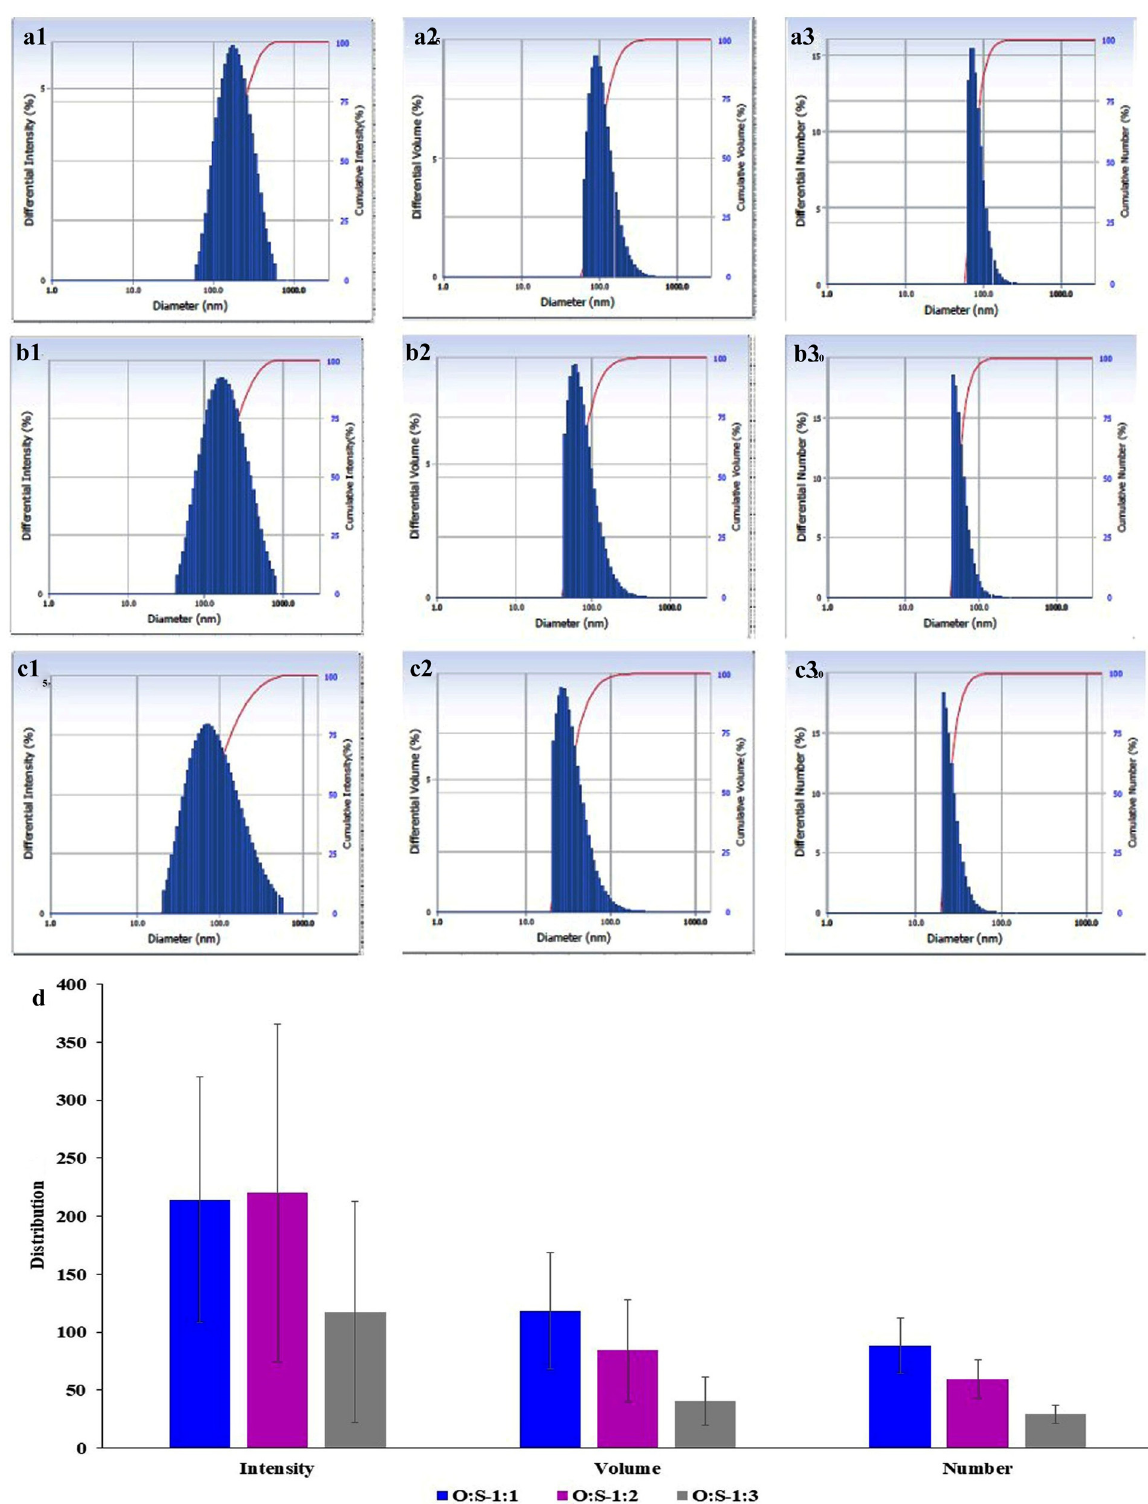
Figure 2: Particle size distribution of EO nanoemulsion, A: oil:surfactant ratio ( O:S ) 1:1 ( a ) , 1:2 ( b ) , and 1:3 ( c ) ( v/v ) ; a1, b1, and c1: intensity %; a2, b2, and c2: volume %; a3, b3, and c3: number %; ( d ) di ff erence in particle size distributions ( nm )